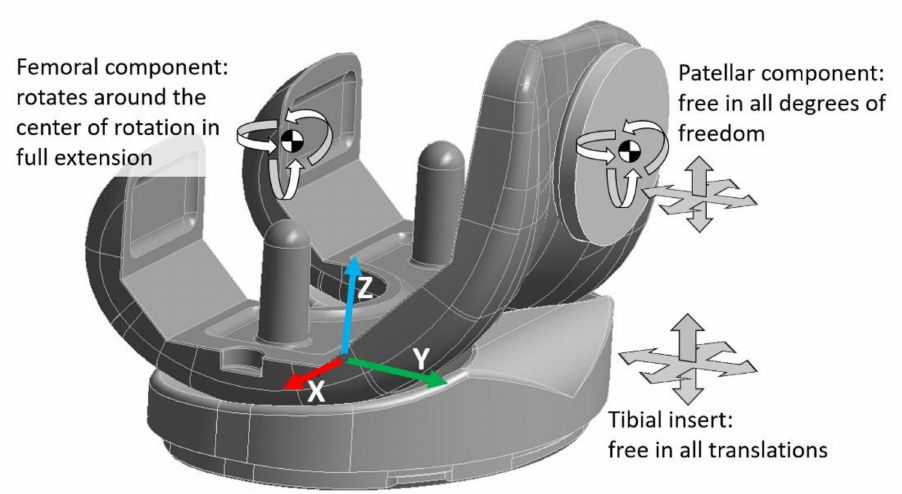
Figure 1. CAD model of the used implant components and the global coordinate